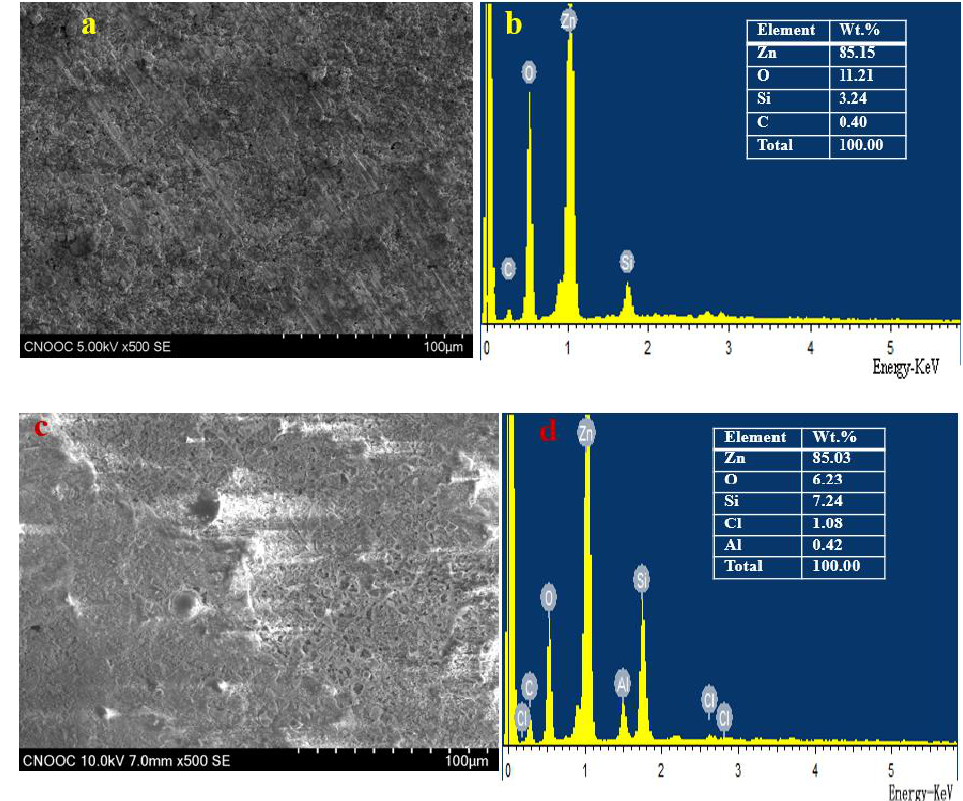
Figure 12. Analysis of the surface microstructure of the inorganic zinc-rich coating: ( a , b ) SEM photograph and EDS pattern of inorganic zinc-rich coating without salt spray; ( c , d ) SEM photograph and EDS pattern of inorganic zinc-rich coating after salt spraying for 7500 h.